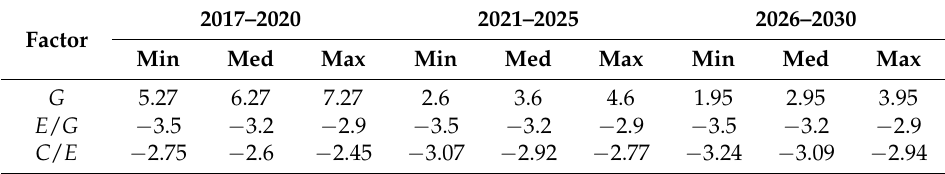
Table 5. Average annual rate of change in each factor under the technological breakthrough scenario. Unit: %.